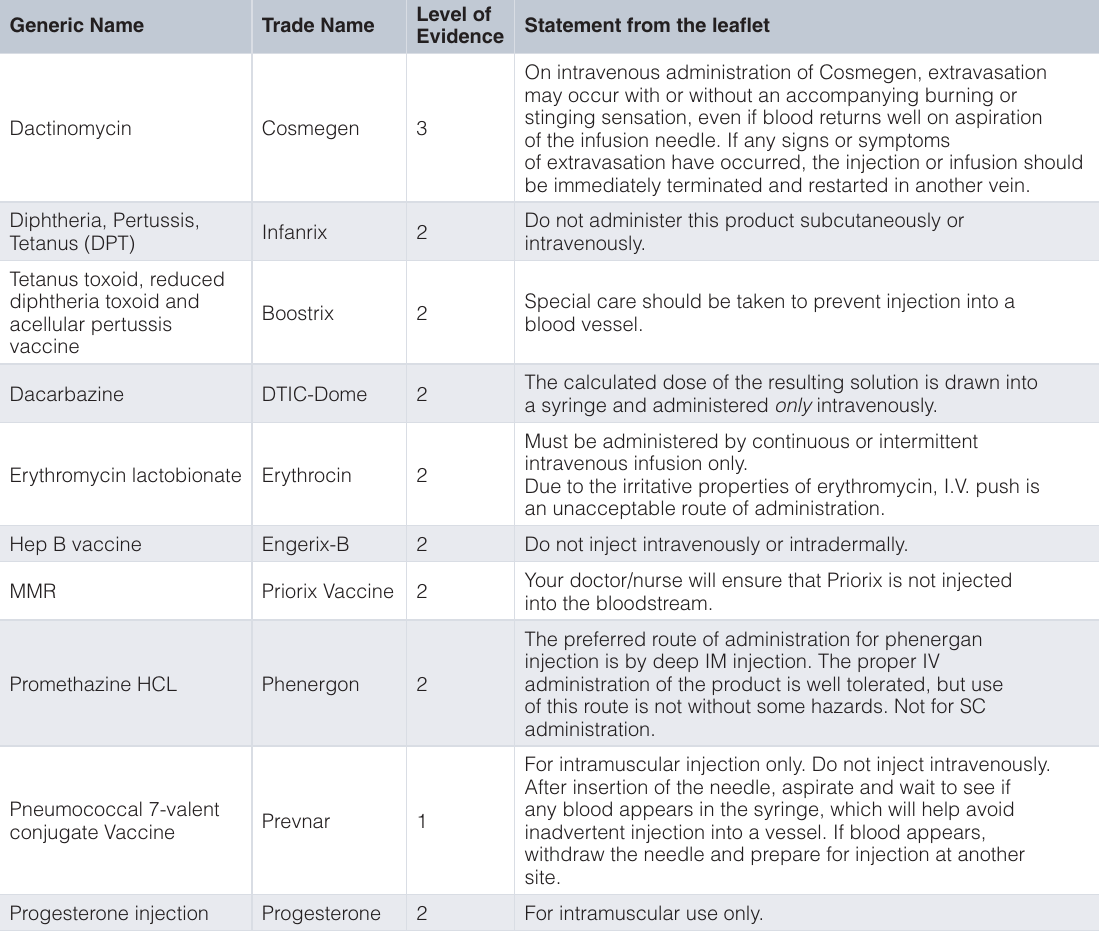
Table 2. Summary of results based on information given in product